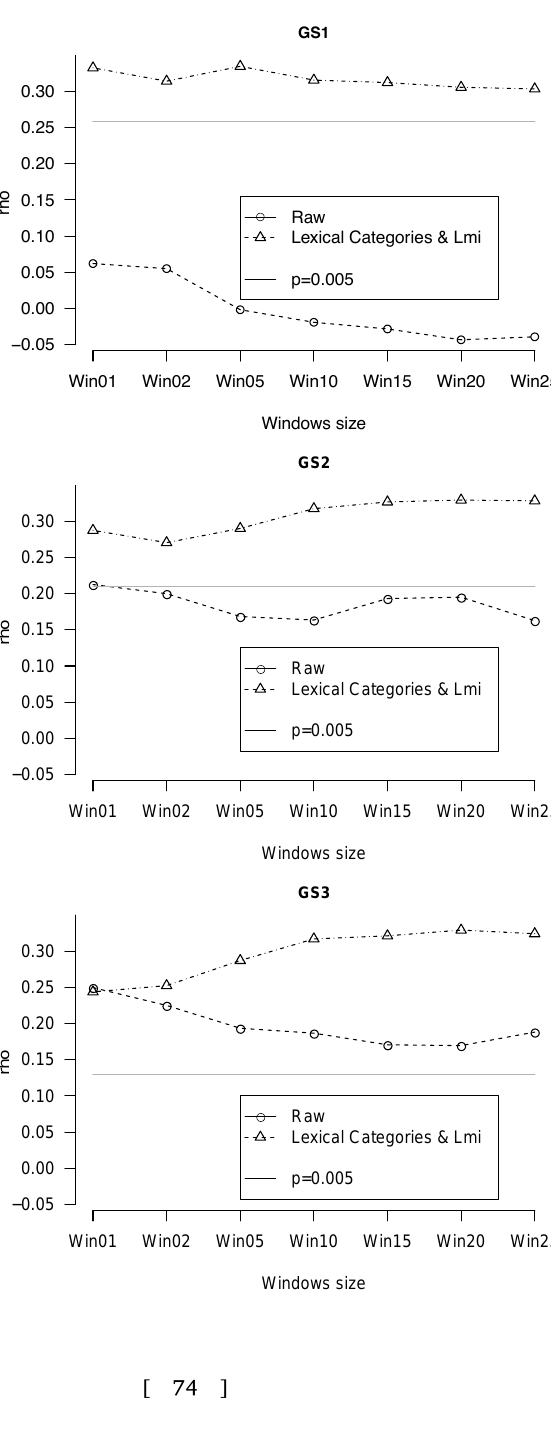
Figure 4: Results for raw frequency models vs. models with content words and